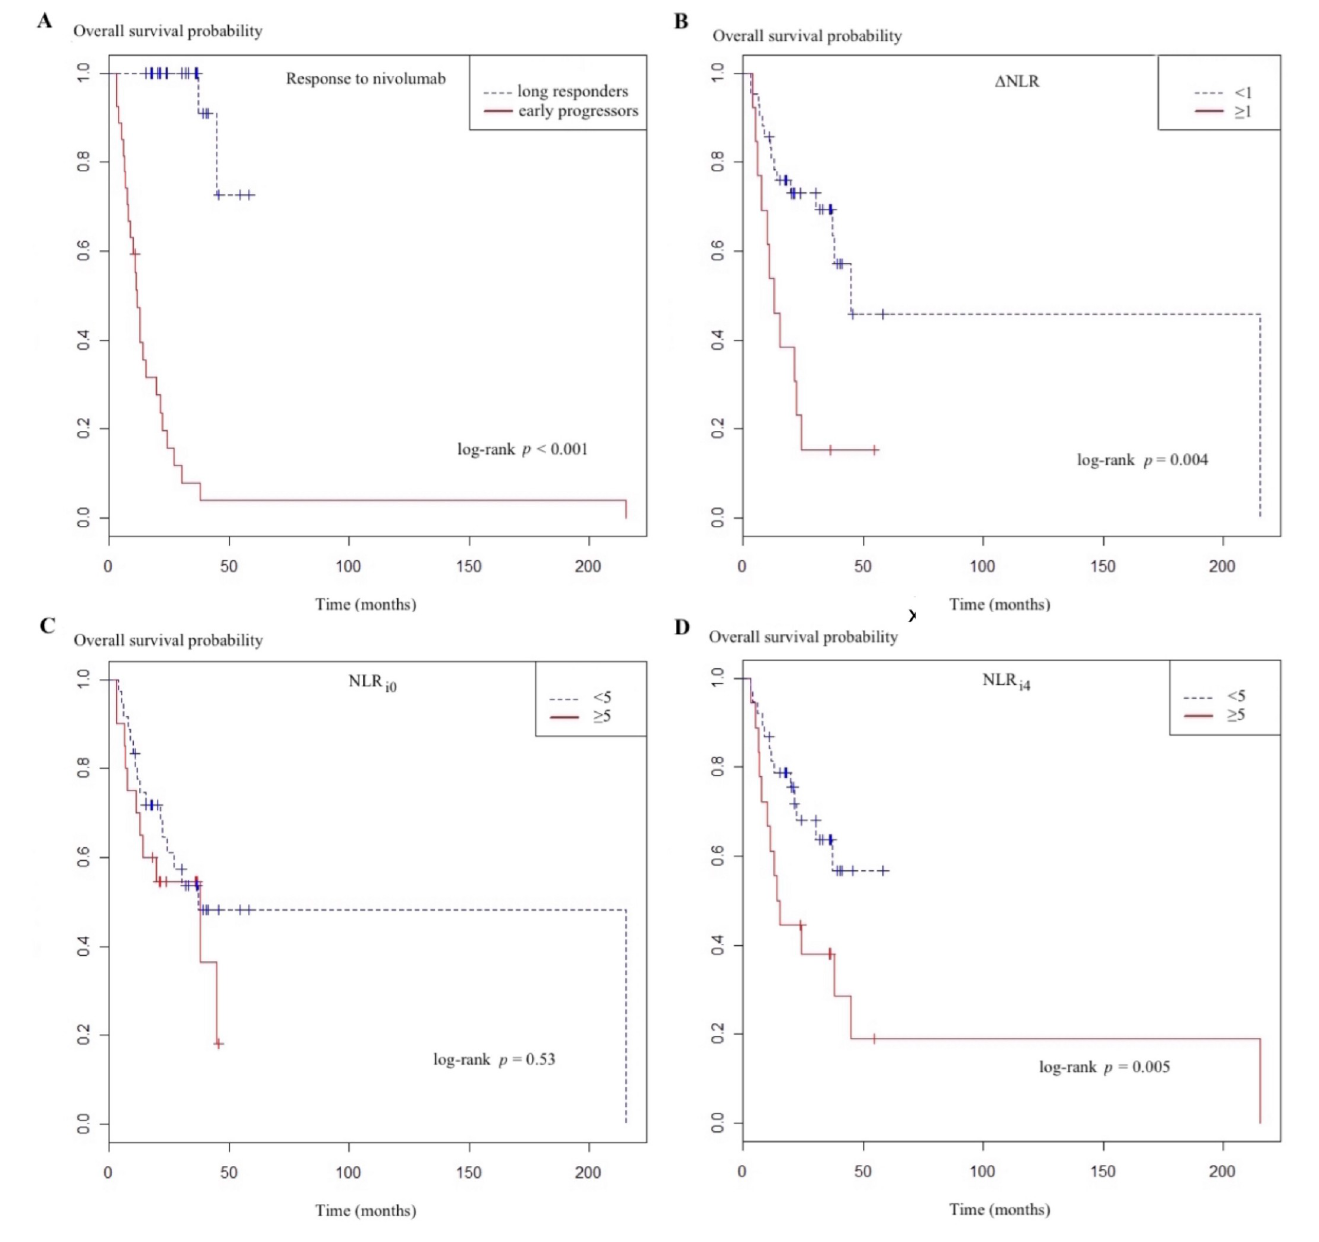
Fig 1. Overall survival probability, according to the response to nivolumab (A), Δ NLR (B), NLR i0 (C) , and NLR i4 (D), (A) response to Nivolumab, (B) Δ NLR (NLR change between the 1 st and 4 th nivolumab infusions), (C) NLR i0 (neutrophil-to-lymphocytes ratio; i0, just before the 1st nivolumab infusion), ((D) NLR i4 (neutrophil-to-lymphocytes ratio i4, just before 4 th nivolumab infusion.